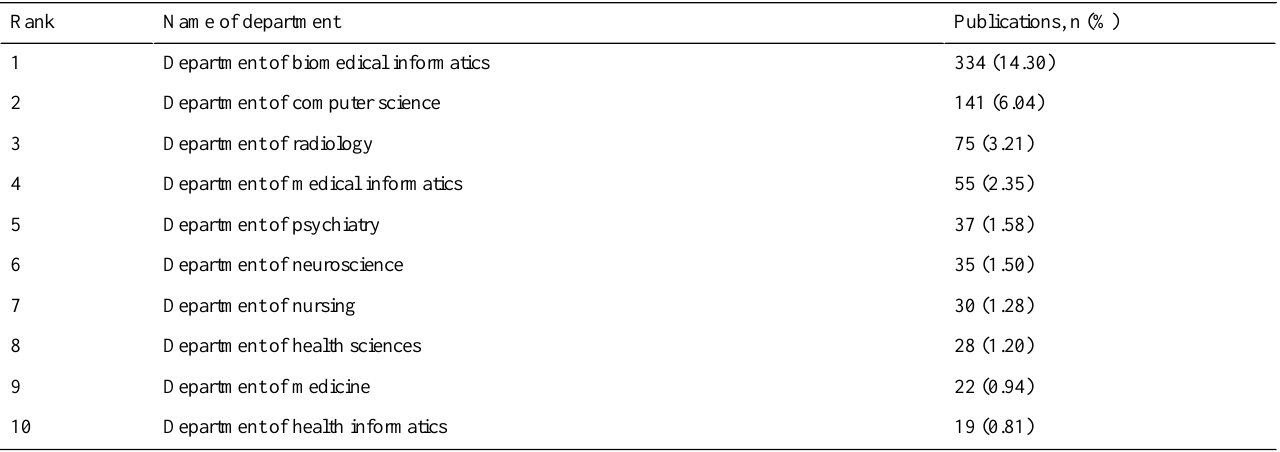
Table 6. Distribution of departments to which the first authors belonged